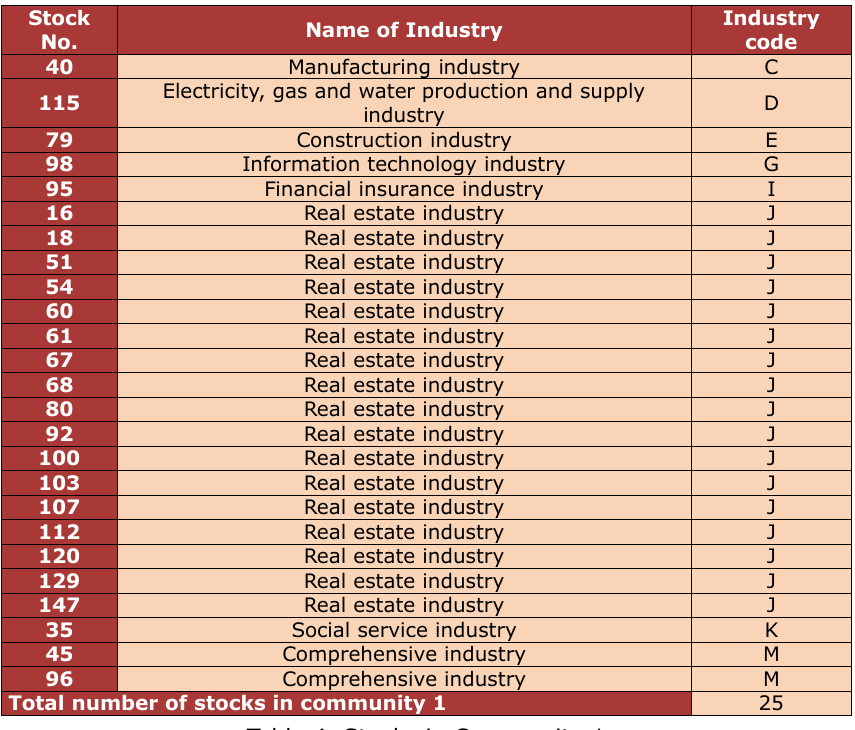
Table 4. Stocks in Community